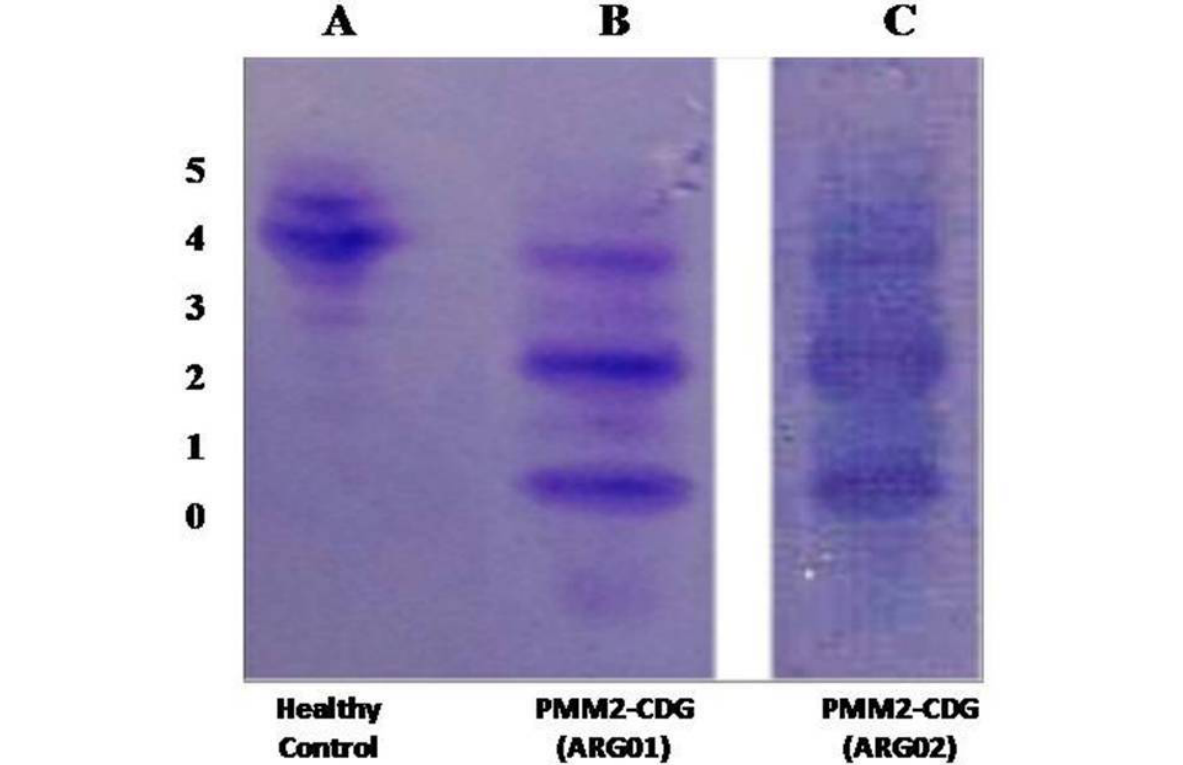
Figure 1. Plasma transferrin isoelectric focusing (TfIEF) analysis. The number of terminal sialic acid residues in plasma transferrin (0-5) is indicated. Line A corresponds to a healthy control subject with a normal TfIEF pattern. Lines B and C correspond to samples from two patients (AR01 and AR02) with a CDG type I pattern consistent with